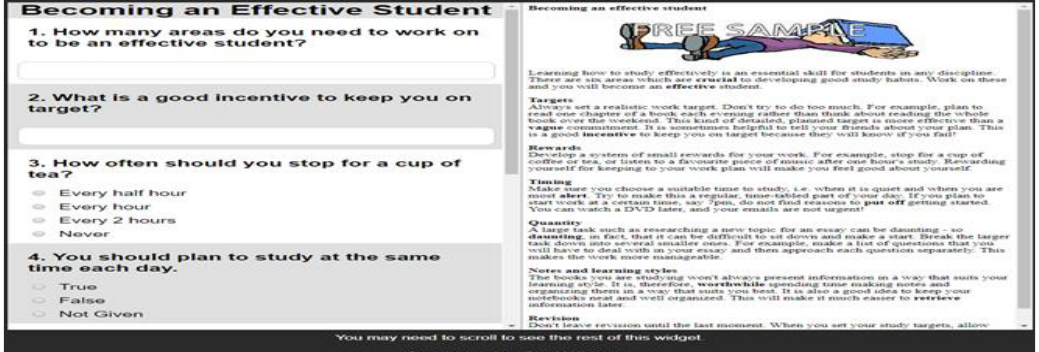
Figure 4 : example online reading